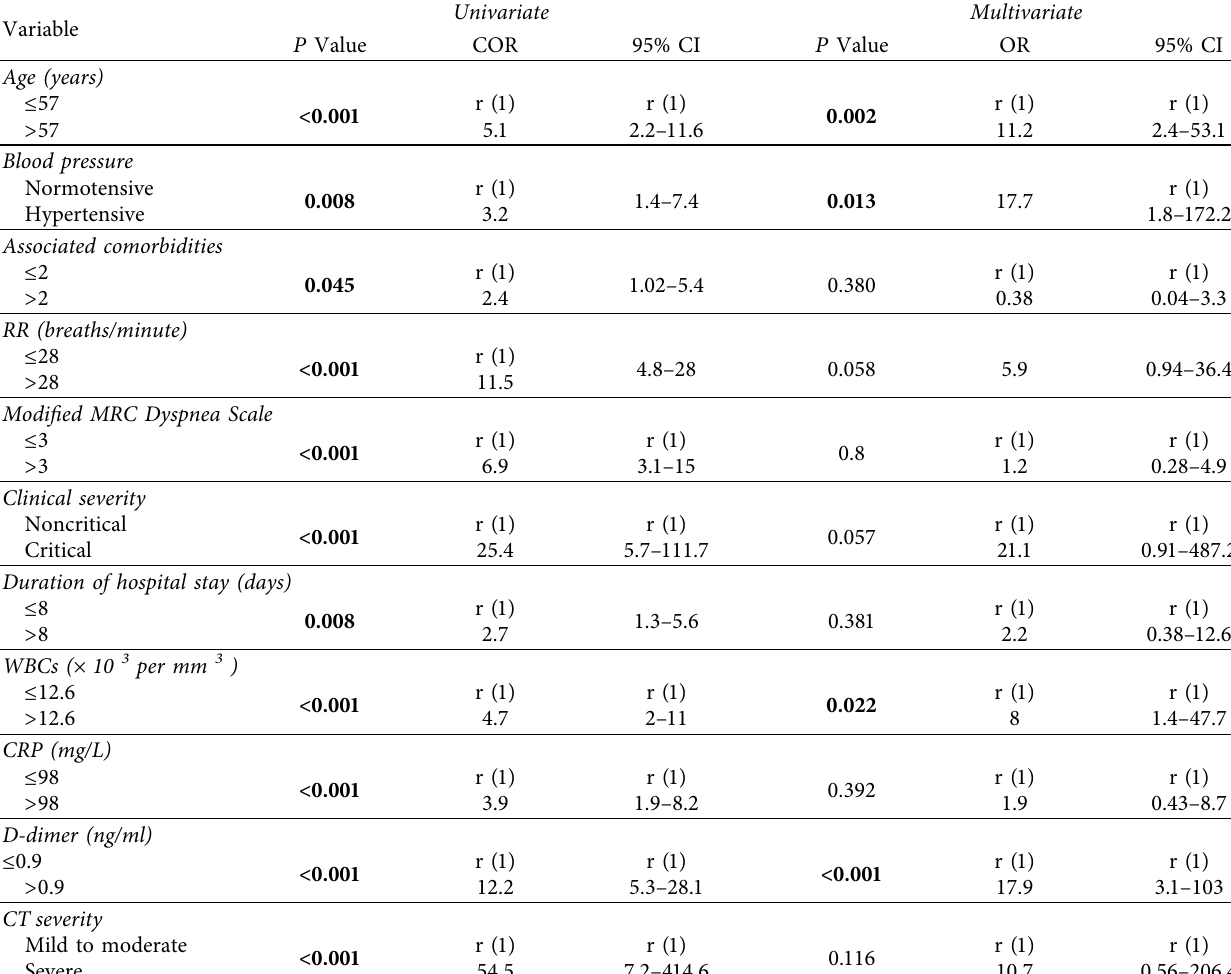
Table 4: Univariate and multivariate logistic regression analyses to identify predictors of mortality in the study COVID-19 patients ( n �